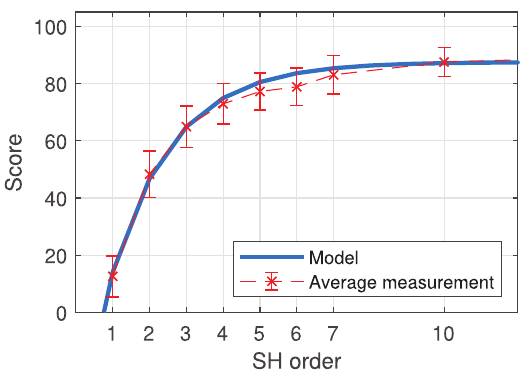
Figure 5. Average measurements with CI 95% and the logarithmic model